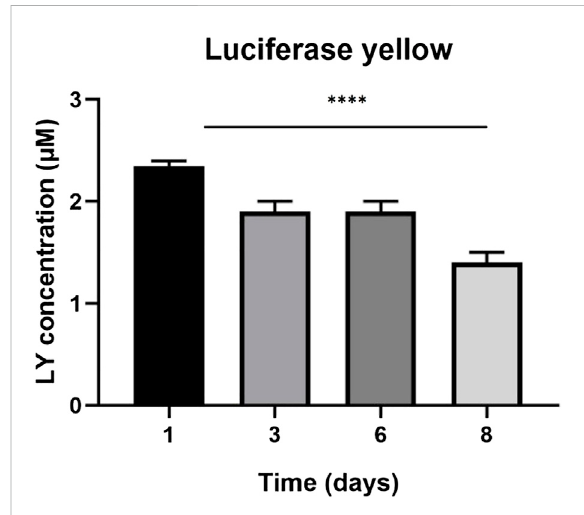
FIGURE 3 Luciferase yellow concentration (µM) across eight days. The graph shows the means ± SEM of three experiments. Statistical analysis was performed through the analysis of variance (ANOVA) and Dunnet ’ s posttest. The differences were considered signi fi cant compared to day one (1). *** p <